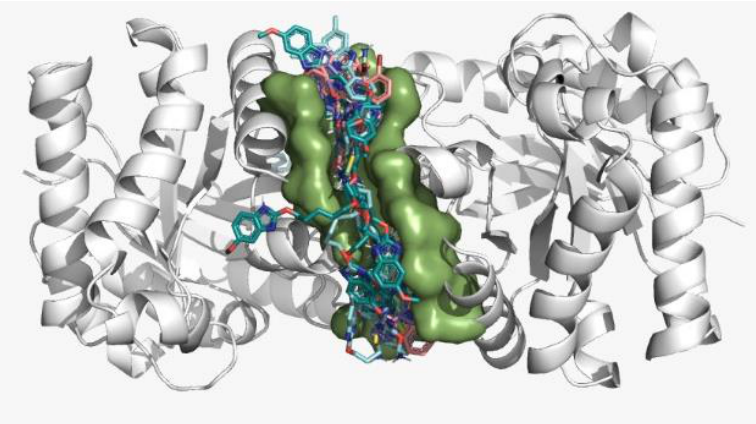
Figure 1. Prediction of the binding site of control compounds by the DoGSiteScorer web server and blind molecular docking on Lm TIM. The protein is represented in gray color, and the dimer interface is represented in green color.